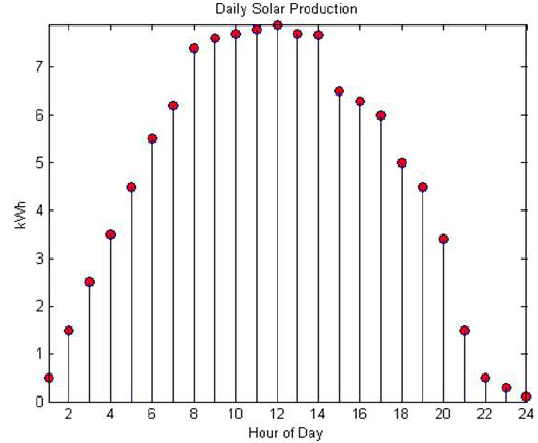
Figure 1: Daily Solar Production [8].